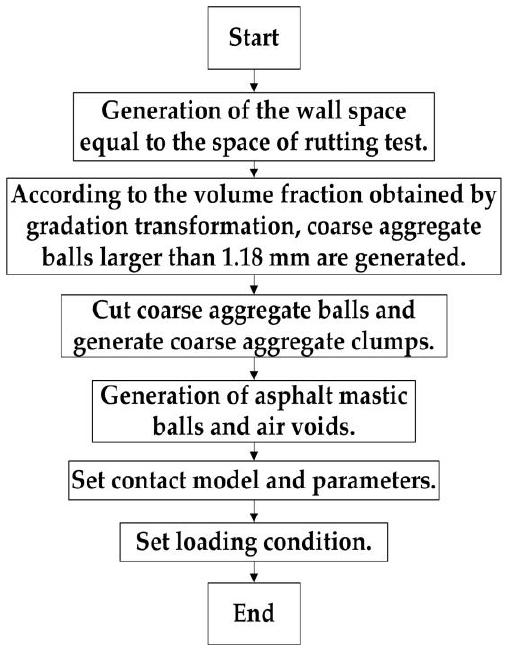
Table 9. Macro parameters of linear contact bond model.